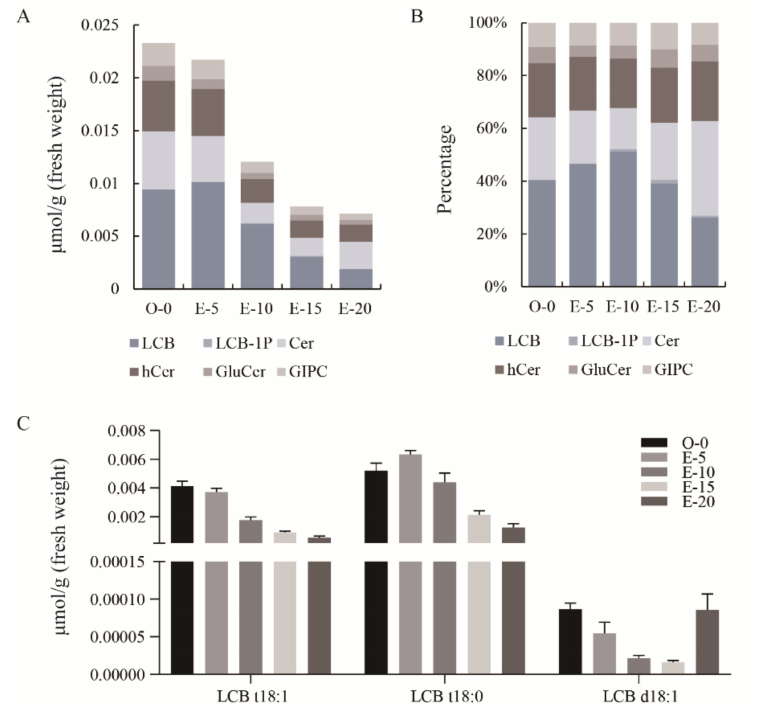
Figure 2. Sphingolipid composition in field-grown upland cotton ovules/embryos at different devel- opmental stages. ( A ) The total content of six major sphingolipid categories in cotton ovules/embryos at five different developmental stages. ( B ) Percentages of the six major categories of sphingolipids in cotton ovules/embryos at different developmental stages. ( C ) Individual sphingosine content of cotton ovules/embryos at different developmental stages. LCB, long chain base; LCB-1P, LCB-1- phosphates; Cer, ceramides; hCer, hydroxyceramides; GluCer, glucosylceramides; GIPC, glycosyl inositol phosphoceramides. O-0 indicates ovules at anthesis. E-5, E-10, E-15, and E-20 indicate embryos 5, 10, 15, and 20 days post anthesis, respectively. Values represent means ± SD ( n =